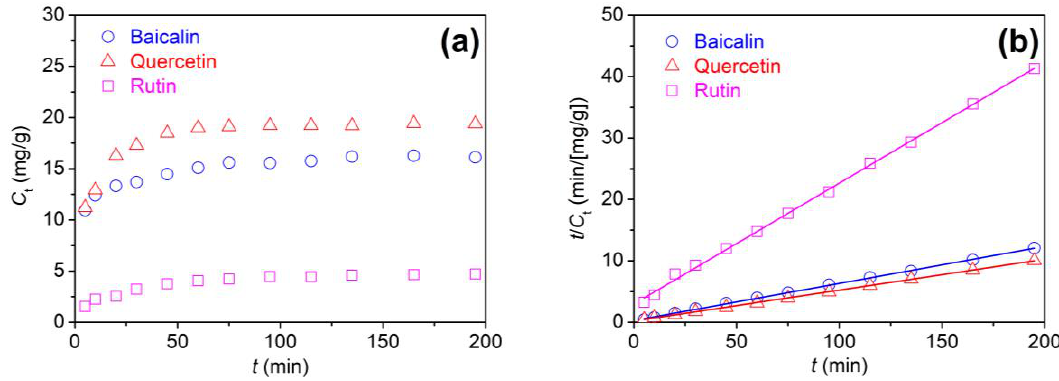
Figure 3. Adsorption rates of three flavonoids for polyamide fiber: ( a ) C t ~ t and ( b ) t / C t ~t.